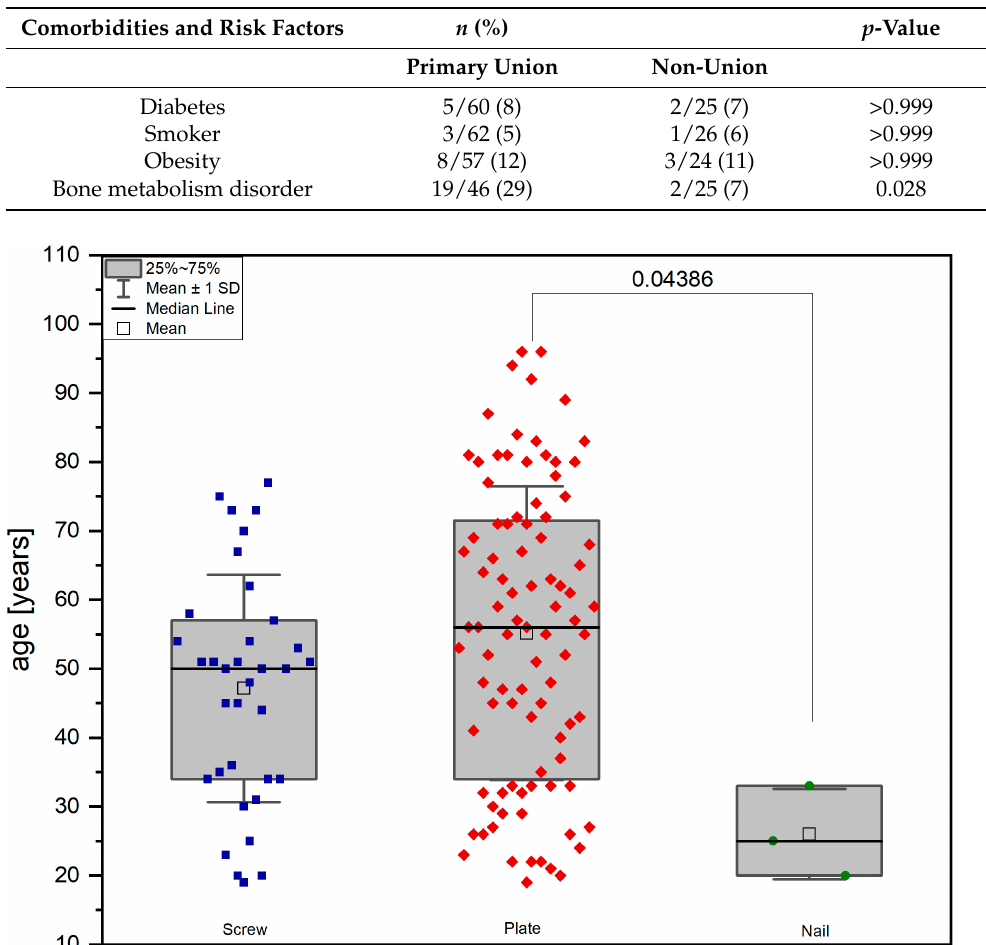
Figure 2. Distribution of age between allocated groups with different fracture management. Hence, statistical analysis was carried out between groups 1 and 2. Three patients in group 1 sustained bilateral distal femoral fractures; 13 bilateral distal femoral fracture in- juries were found in group 2. A tabular overview of demographic data, fracture entities, and postoperative complications is given in Table 2.